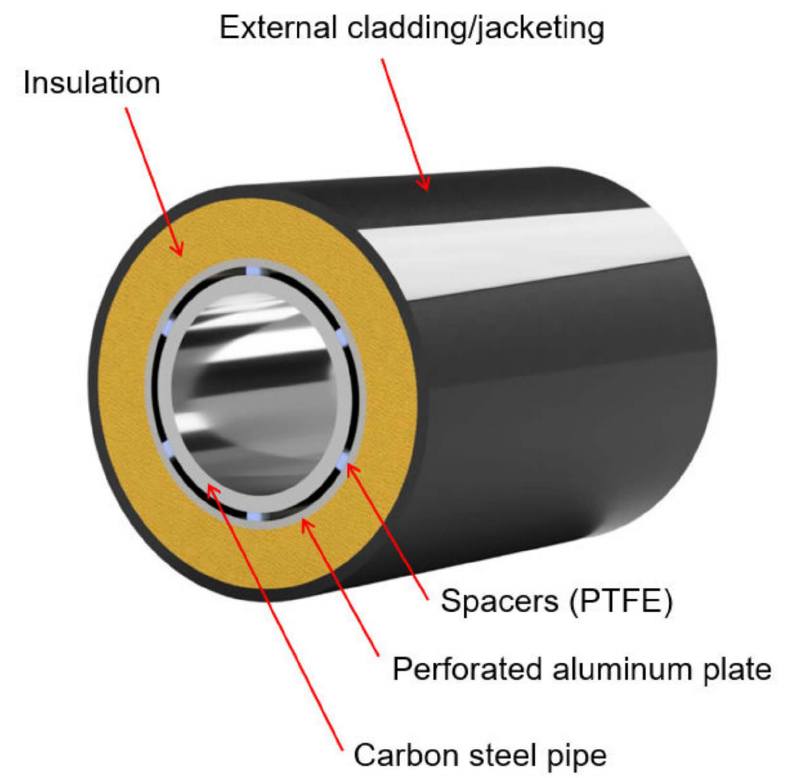
Figure 2. Schematic of “non-contact” or “distance-insulation” system